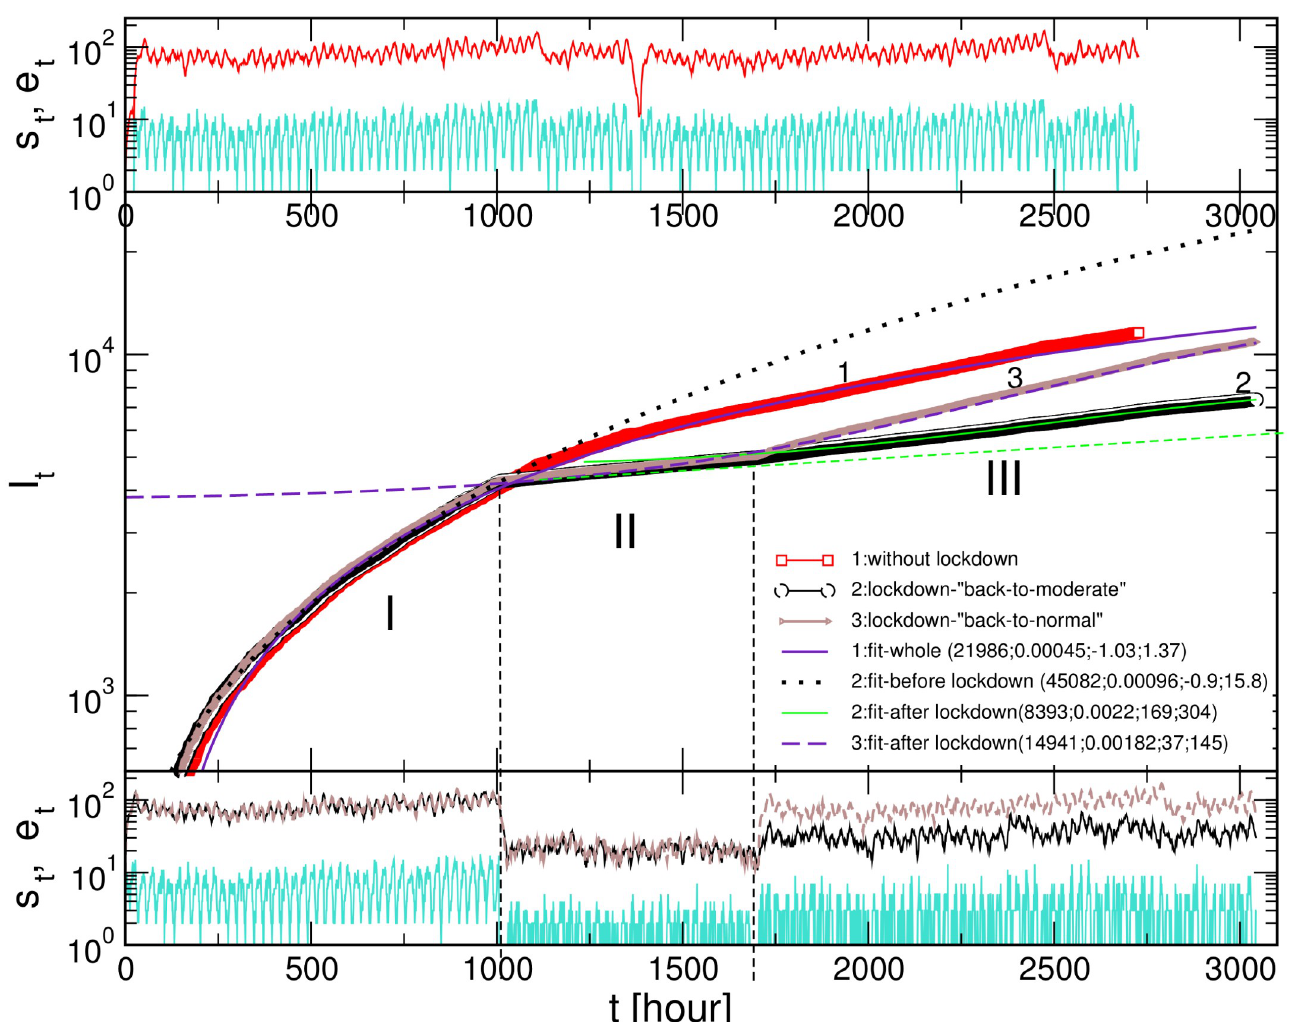
Fig 7. Simulations of exiting scenarios. Central panel: Infection curves I t vs time for the extended period with the naturally fluctuating social dynamics, curve (1), and for two scenarios with the lockdown intervention followed by moderate-intensity dynamics (2) and “back-to-normal” scenario (3). Periods before, during, and after lockdown are indicated as I, II, III. The fluctuating intensity of the susceptible s t and exposed e t agents corresponding to the case (1) are shown in the top panel, and to the curves (2) and (3) in the bottom panel. The last part of the signal s in the case “back-to-normal” corresponds to the second half of the t signal in the top